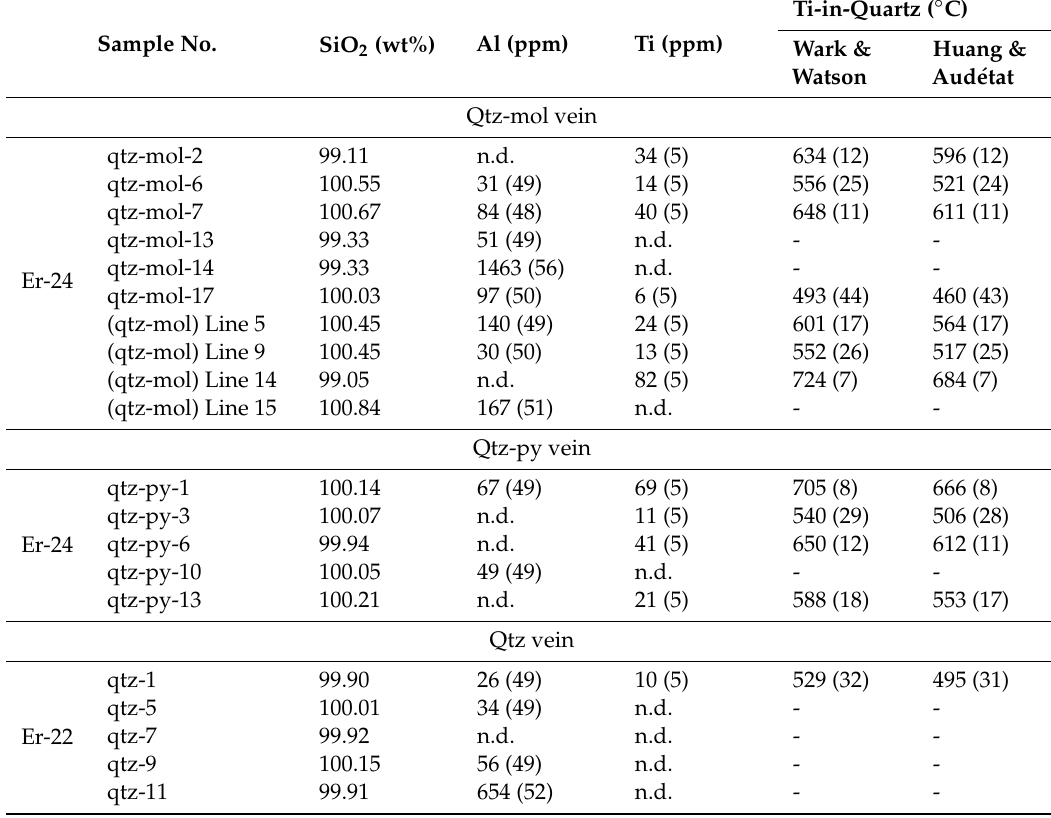
Table 3. Representative trace element contents of quartz veins and minimum temperatures calculated using Ti-in-quartz geothermometry (number in parentheses next to each analysis represents 1 σ and given in the term of the least unit cited; n.d. = not detected).